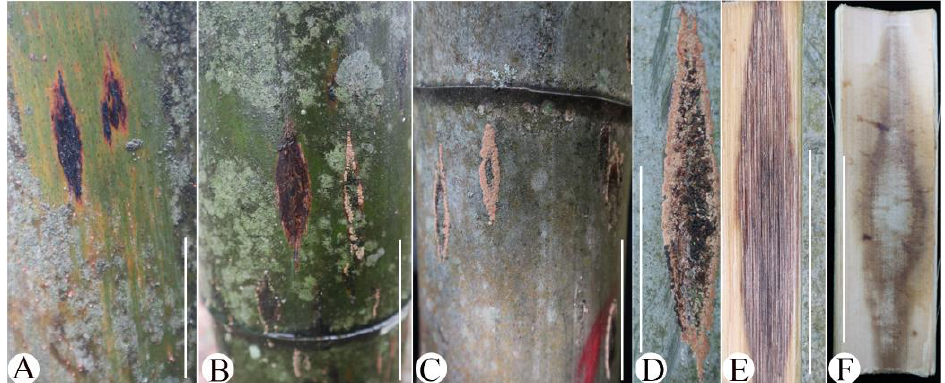
Figure 1. Symptoms of moso bamboo ( Phyllostachys edulis ) culm rhomboid rot disease in bamboo forests. Scale bar: 5 cm. ( A ) Black spots and rhomboid shape symptoms on the outer surface; ( B ) Symptoms covered with a complex of dirt, moss, and sooty mold; ( C ) Macroscopic pink fungal ascomata appeared, surrounding the spots; ( D ) Rhomboid shape symptoms with sooty mold and pink fungal ascomata; ( E , F ) Necrosis occur on the inner cavity of the